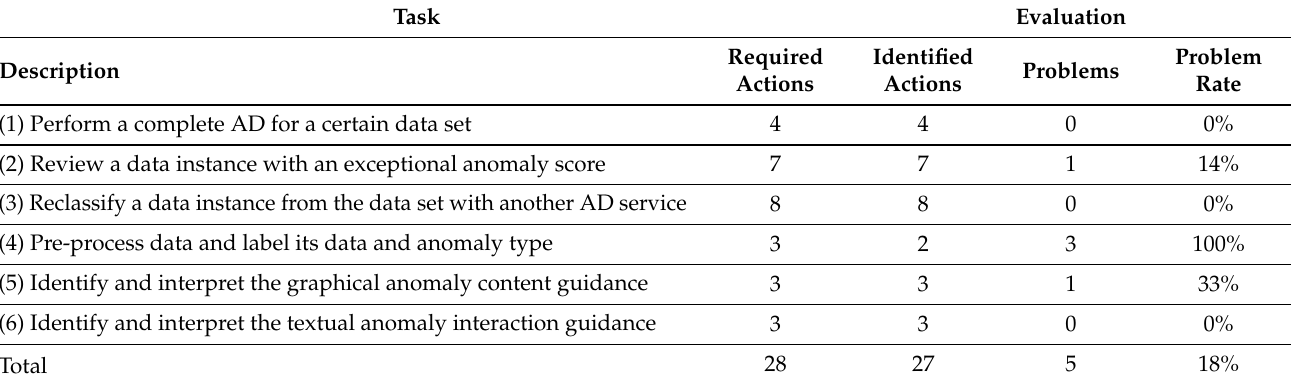
Table 2. Cognitive walkthrough results with tasks for the insurance user stereotype.